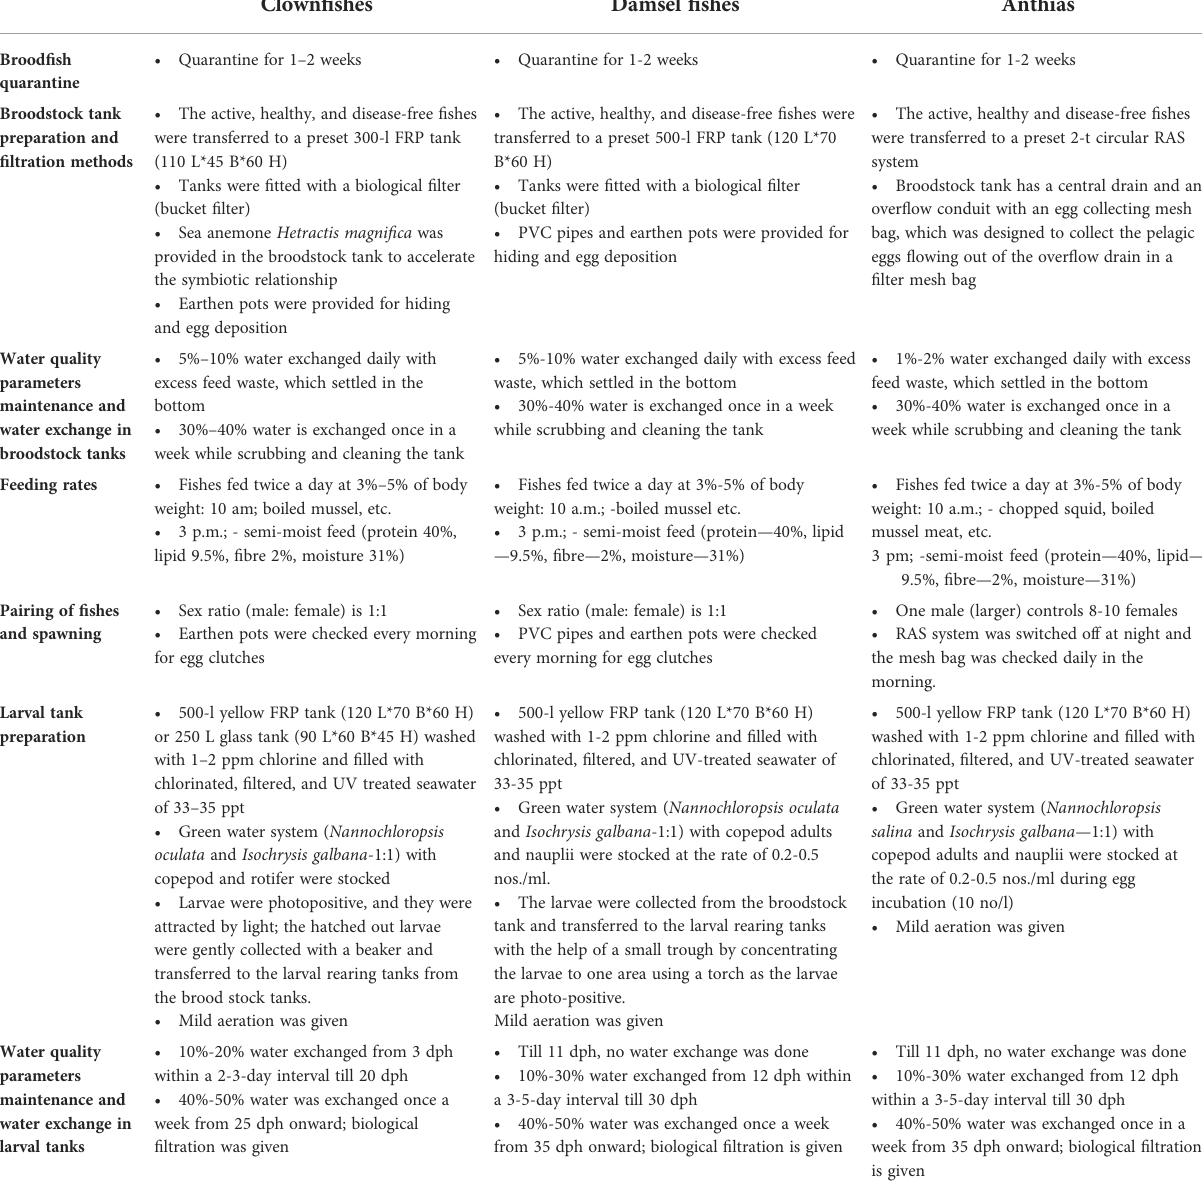
TABLE 8 Standard operating procedures (SOPs) for ornamental fi sh breeding and larval rearing. Clown fi